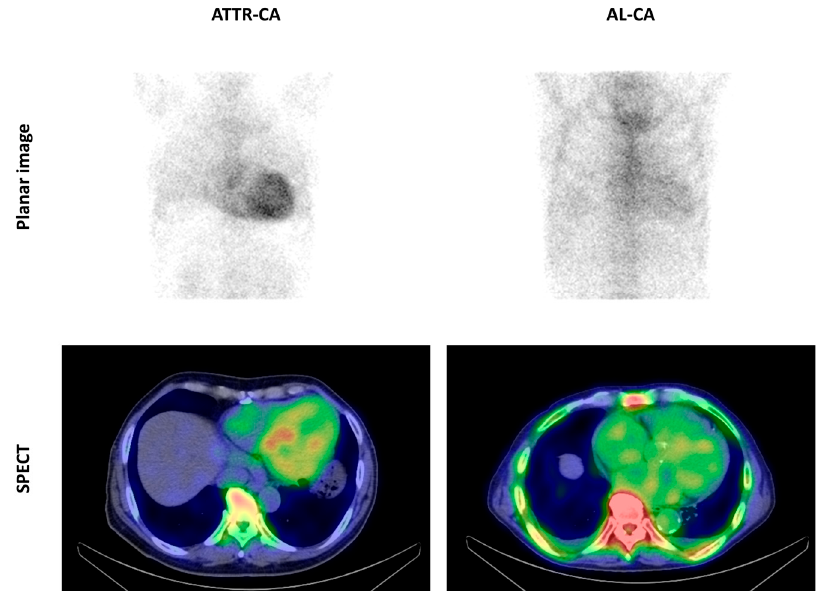
Figure 1. Cardiac uptake of 99m Tc-PYP in patients with cardiac amyloidosis. The upper left shows a planar image of a patient with transthyretin cardiac amyloidosis (ATTR-CA) and the lower left shows a SPECT image of the same patient. The upper right shows a planar image of a patient with amyloid light-chain cardiac amyloidosis (AL-CA), and the lower right shows a SPECT image of the same patient. The heart-to-contralateral ratios were 2.0 in the patient with ATTR-CA and 1.2 in the patient with